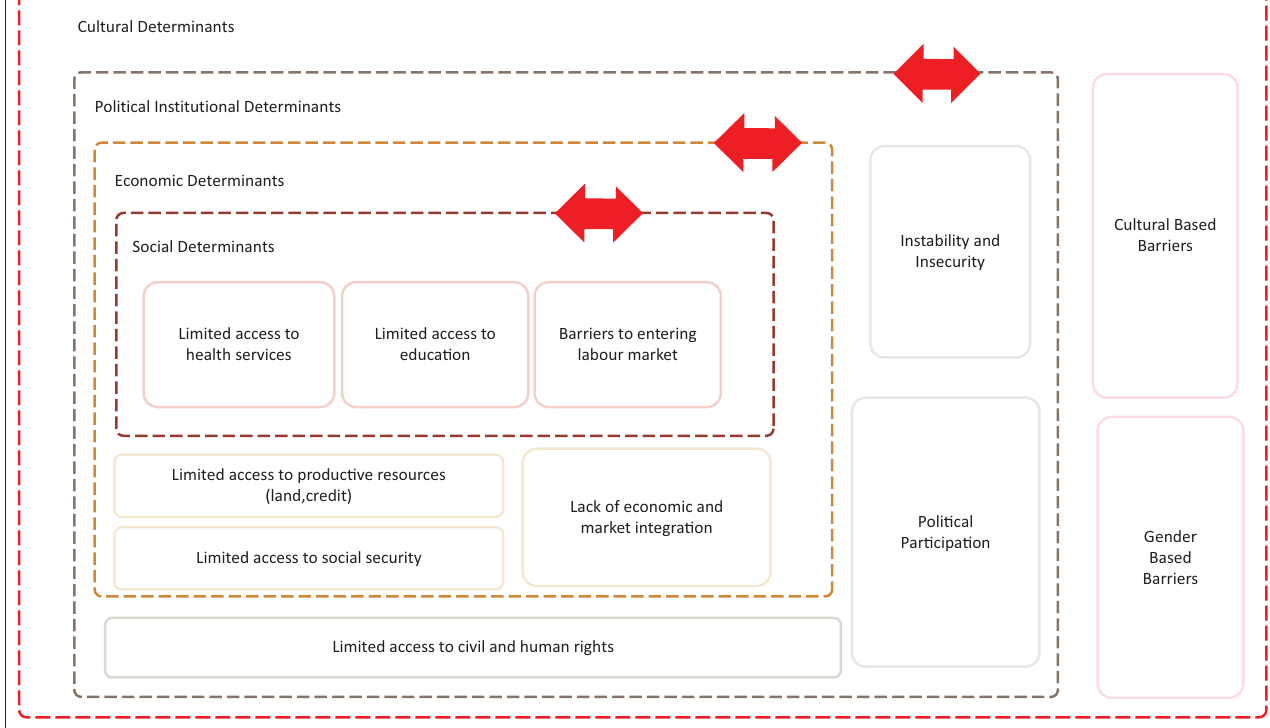
FIGURE 2: Showing determinants of human exclusion proposed by the United Nations Economic Commission for Africa.